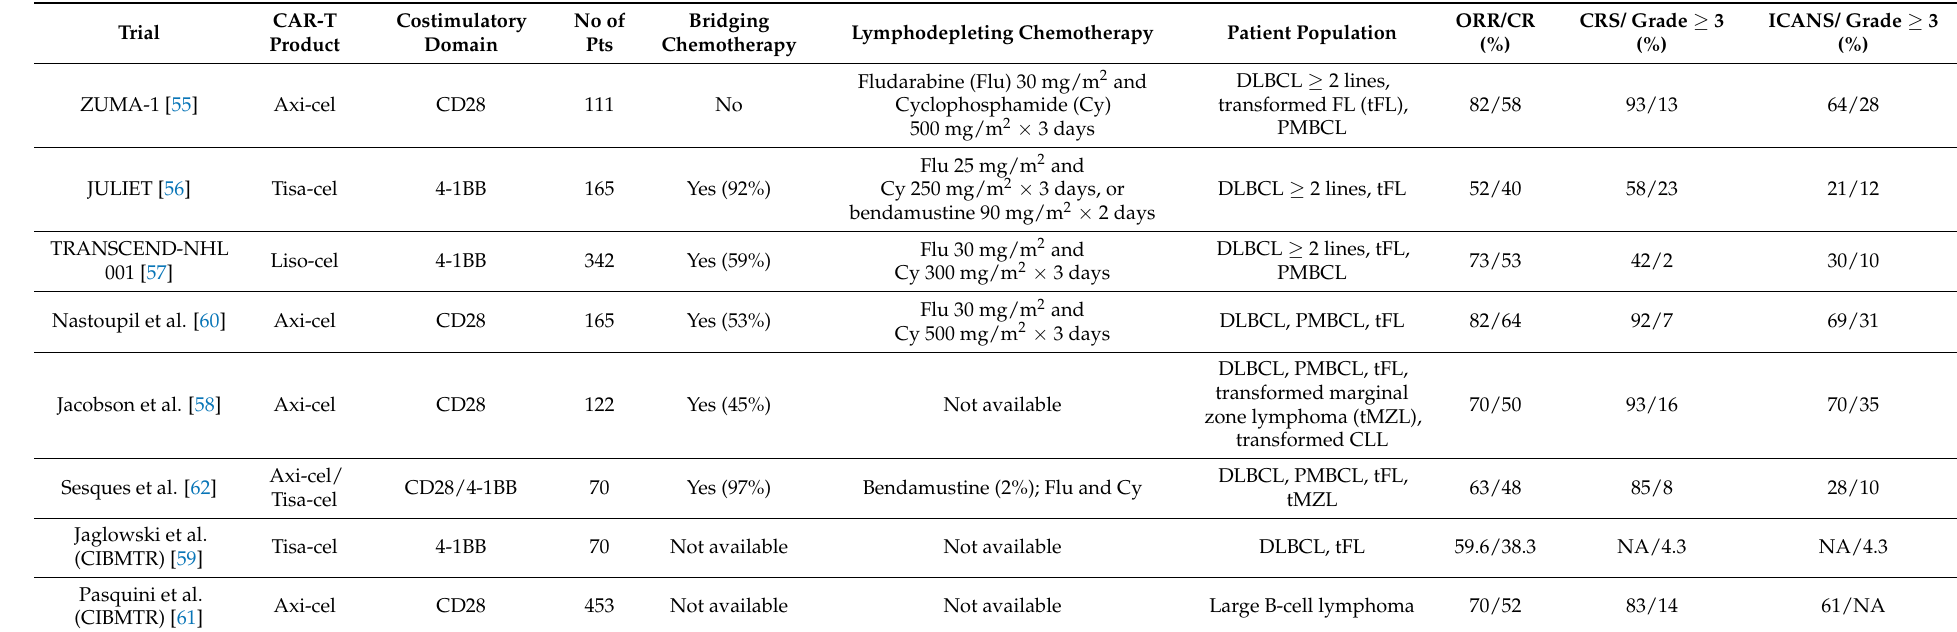
Table 2. Clinical trials of CAR T-cell therapy in